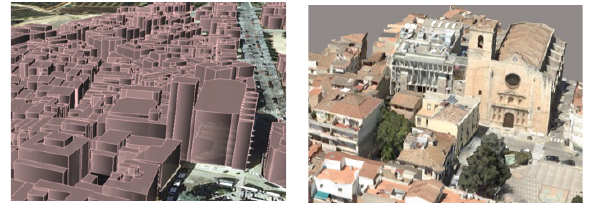
Figure 3 Multiple views collected by the oblique camera